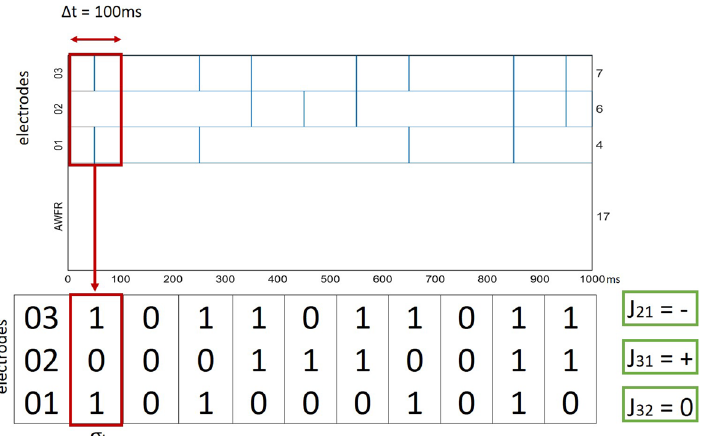
Figure 2. Visualization of the MaxEnt J ij . Top graph shows simulated activity recorded from 3 electrodes during a period of 1 s . Left vertical axis shows electrodes numbers and stimulation (empty; spontaneous activity). Right vertical axis shows total number of recorded spikes per electrode. Horizontal axis: time in ms . Bottom panel shows the binary vectors (cid:31) σ i calculated using a (cid:31) t of 100 ms . From the binary vectors it is then possible to estimate the nature of the different J ij . J ij is negative if the two electrodes have an inhibitory connection, positive if the connection is excitatory and 0 if there is no connection.